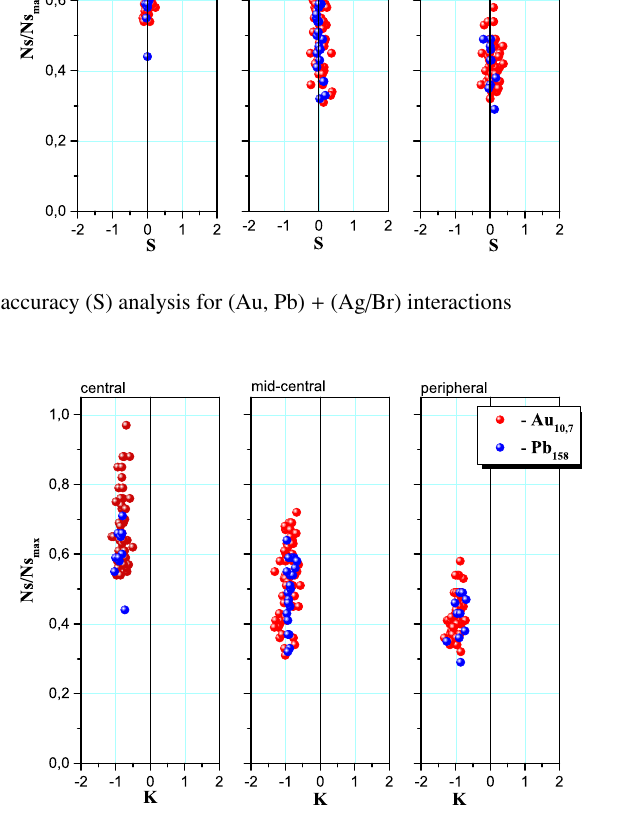
left (proton-spectators), middle (proton + alpha-particle-spectators) and right frame (pro- ton + alpha + heavy mass fragment-spectators). All correlation panels have shown centrality intervals with the most central collisions in the top-left, whereas with the most peripheral ones in the